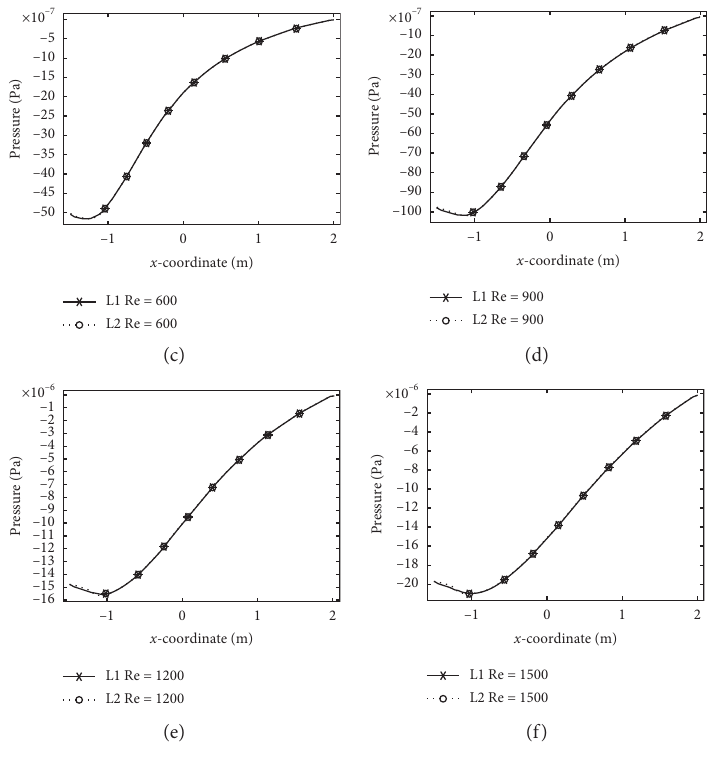
Figure 10: Pressure in lines L1 and L2.